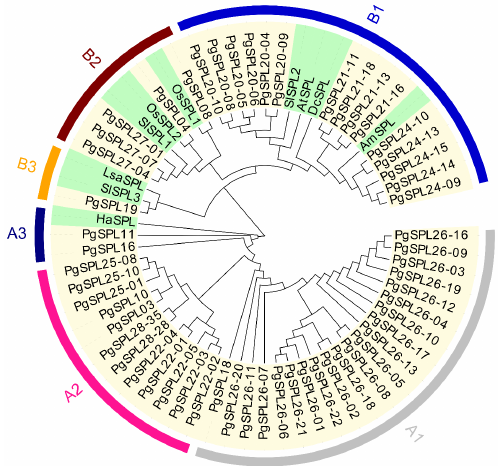
Figure 2. Phylogenetic tree of the SPL gene family in Panax ginseng and 7 other species. Yellowish in the inner circle indicates the Panax ginseng of SPL gene ( PgSPL ); Greenish in the inner circle indicates the Arabidopsis thaliana ( AtSPL ), Antirrhinum majus ( AmSPL ), Daucus carota ( DcSPL ), Helianthus annuus ( HaSPL ), Lactuca sativa ( LsSPL ), Oryza sativa subsp. Japonica ( OsSPL ) and Solanum lycopersicum ( SlSPL ) of SPL gene . 3.4. Synonymous and Nonsynonymous Substitution Rates and Selective Pressure in PgSPL To explore the evolutionary pressure, we calculated the synonymous and nonsynonymous substitution rates (Ka/Ks) of PgSPL transcripts and compared them to the Ka/Ks ratio in other species. PgSPL 03 and PgSPL 24-10 were selected to calculate the Ka/Ks ratio using YN00 of PAMLX software. The result showed that all of the Ka/Ks ratios are lower than 1. To be specific, the average number is 0.25 with CV = 78%. The lowest one was 0.11 between PgSPL03 and Antirrhinum majus , and the highest one was 0.88 between PgSPL24-10 and Daucus carota . In ginseng, the Ka/Ks ratio between PgSPL 03 and PgSPL 24-10 was 0.21. Interestingly, Daucus carota is one of the species that have the closest phylogenetic relationship with ginseng, but its Ka/Ks ratios had a big difference with ginseng. If the DcSPL were excluded from the calculation, the average would be as low as 0.18 with a CV = 29%. All of these results indicated that SPL genes in eight species above had been undergoing a strong purifying selection.